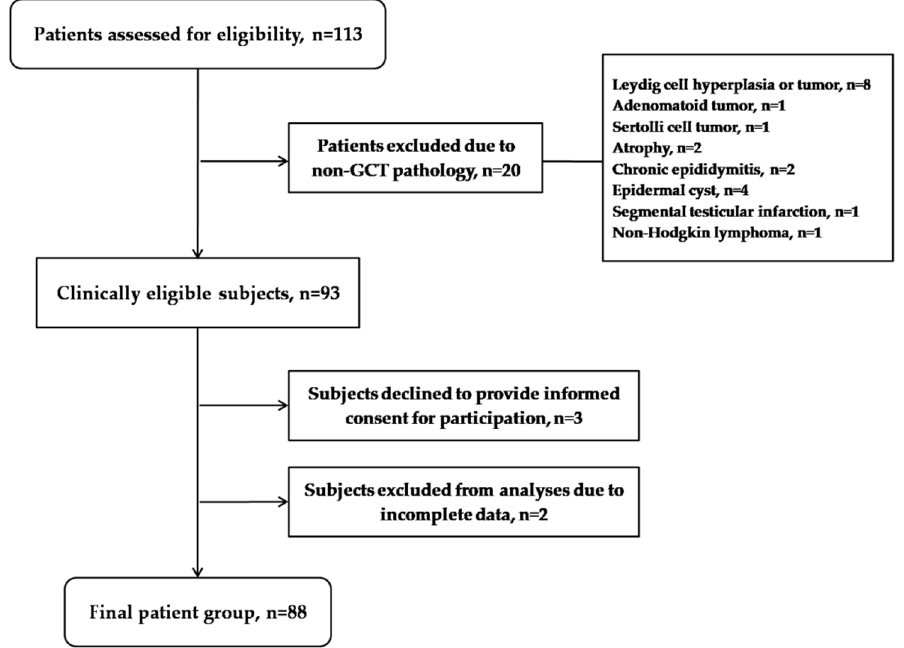
Figure 1. The flowchart detailing the patient enrollment process.